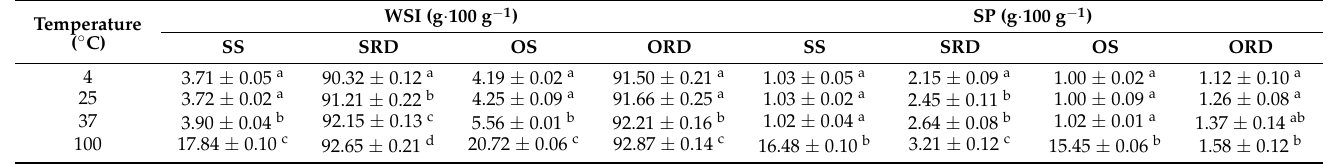
Table 1. The solubility and expansibility of sorghum/oat starch and sorghum/oat resistant dextrin. Temperature ( ◦